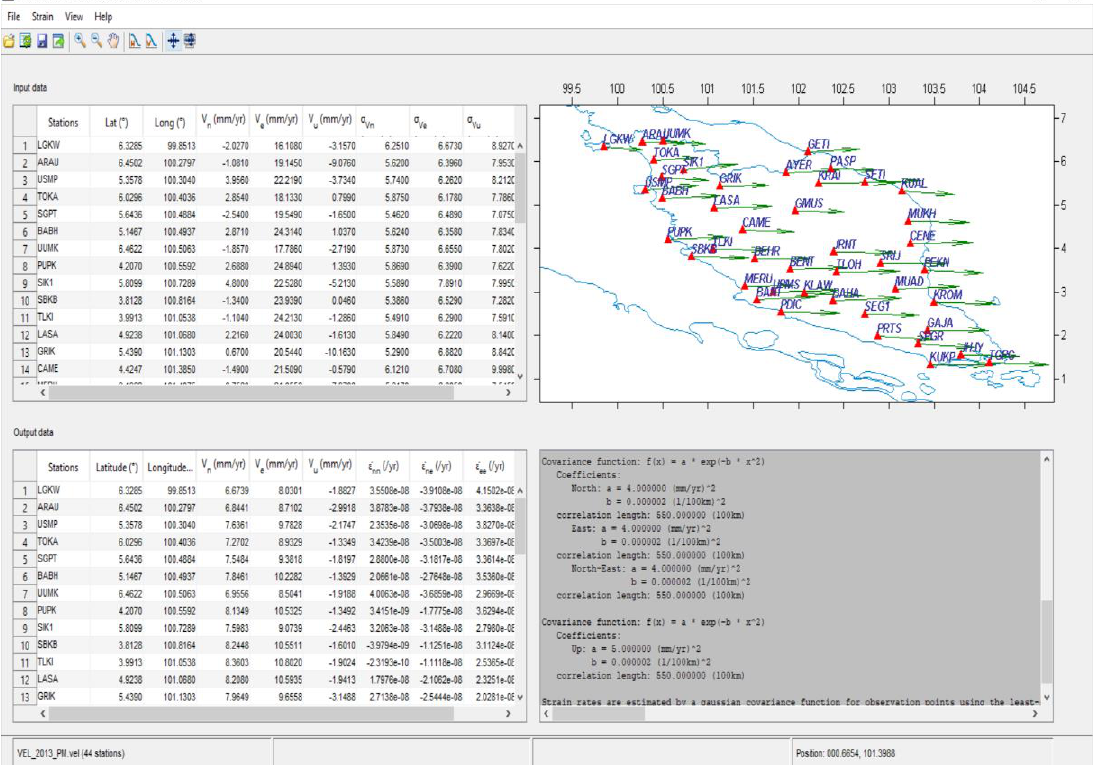
Figure 5. Geostrain software in MATLab environment (Gourdarzi et al ., 2015)